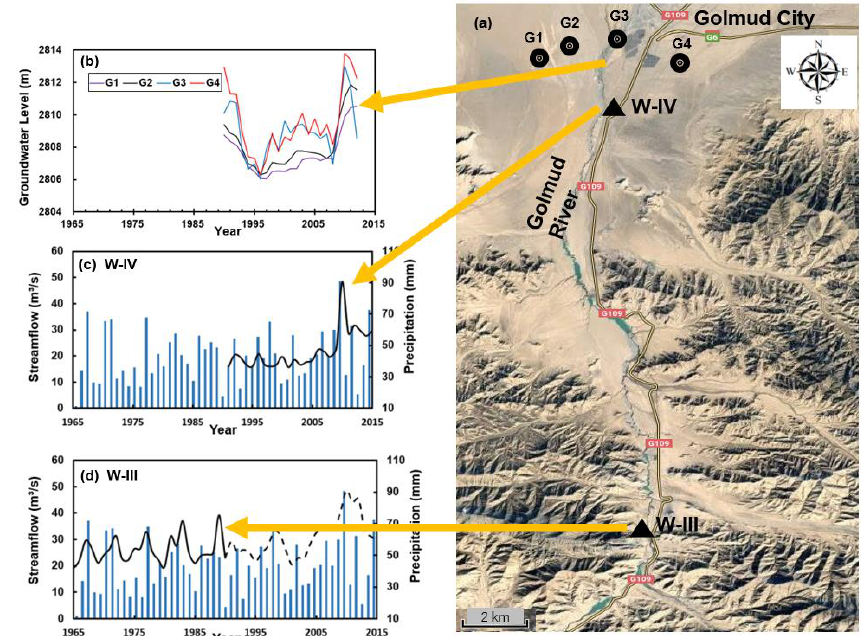
Figure 4. Locations of hydrological stations and observation wells ( a ) with available groundwater level data ( b ). Streamflow observed at W-IV ( c ) and W-III ( d ) in different periods. Dashed line in ( c )